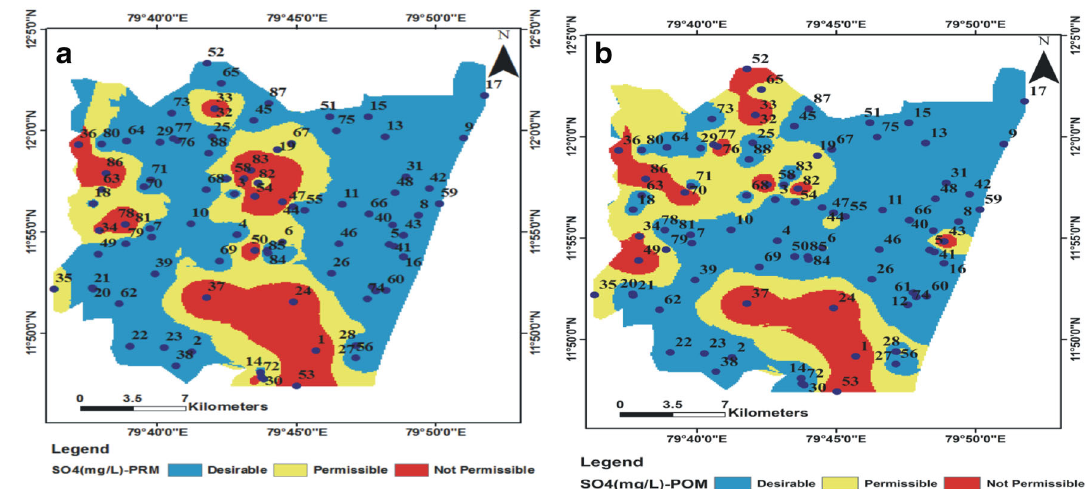
Fig. 11 a , b Spatial distribution map of SO4 (pre- and post-monsoon)